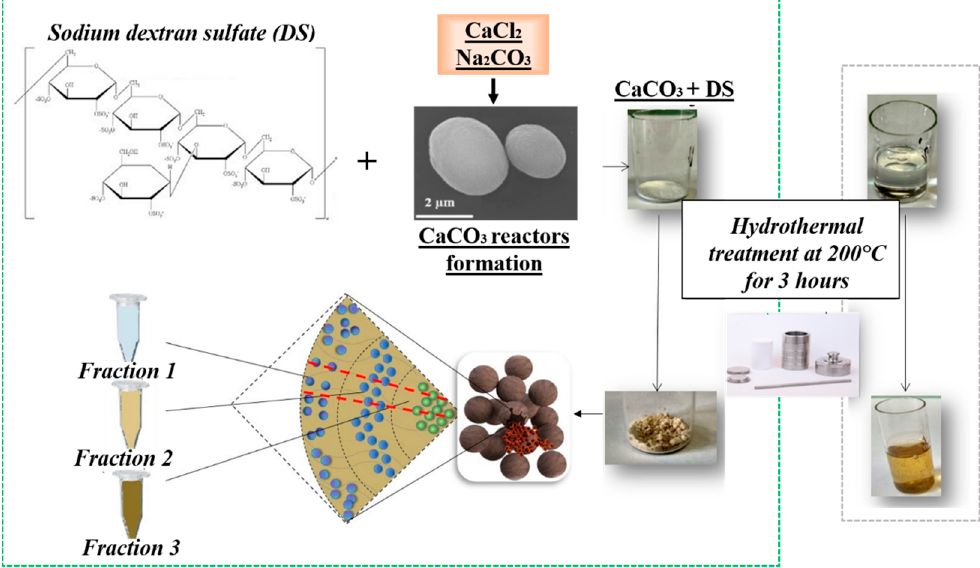
Figure 2. A schematic illustration of CNPs formation in CaCO 3 reactors ( left ) and bulk solution ( right ). (Adapted with permission from Reference [10], Copyright (2018) Nature Publishing Group).